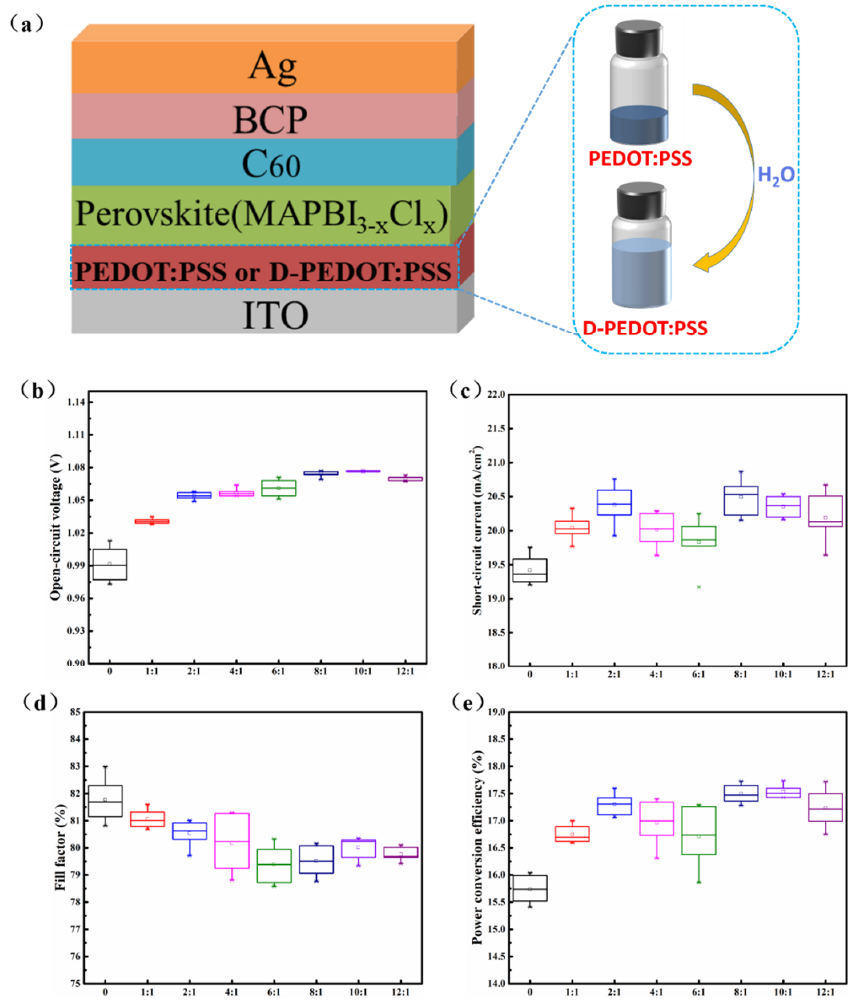
Figure 1. ( a ) Schematic diagram of device structure and preparation of D-PEDOT:PSS hole transport material solution; Photovoltaic parameters of devices with different PEDOT:PSS dilution ratios: ( b ) J SC ; ( c ) V OC ; ( d ) FF; ( e ) PCE.